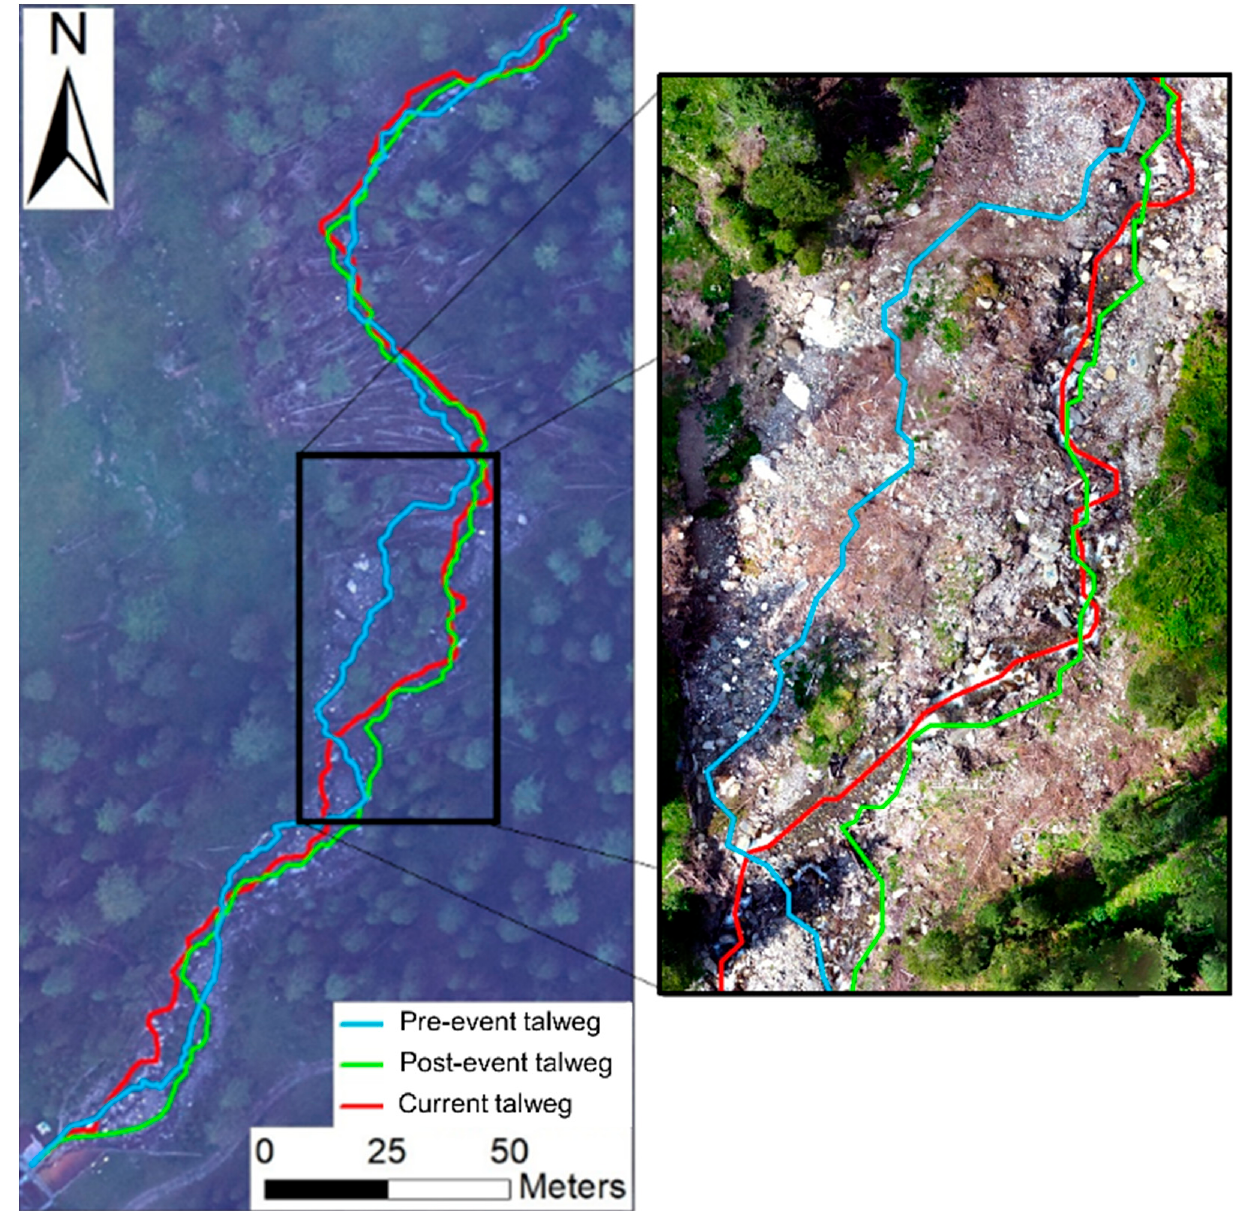
Figure 5. Visual planimetric changes of the talweg for the pre-event, post-event and current conditions. The aerial photo refers to the post-event condition. In the right part, a focus on the new avulsion created during the Vaia storm is shown.